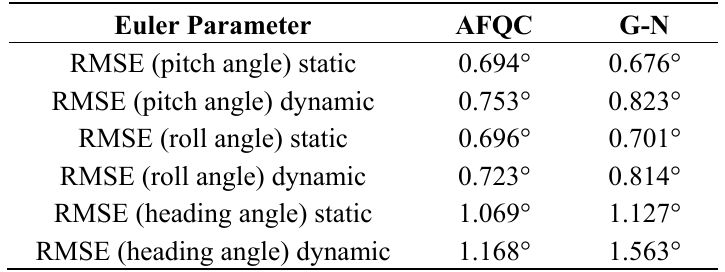
Table 1. The RMSE of AFQC and N-G without